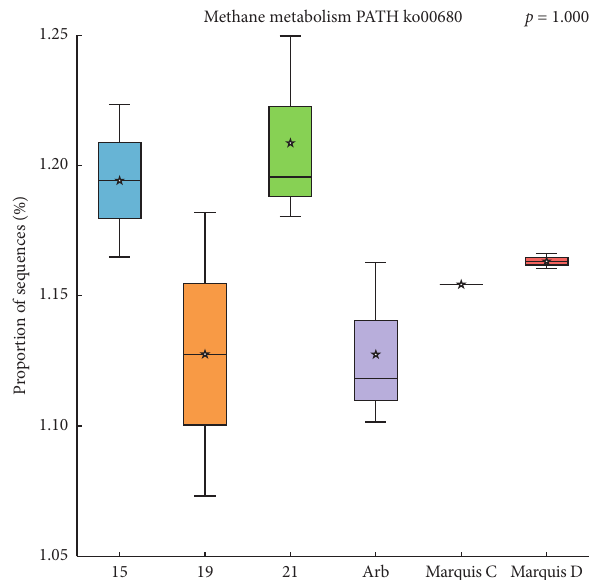
Figure 12: Comparison by field of proportion of sequences in the methane metabolism